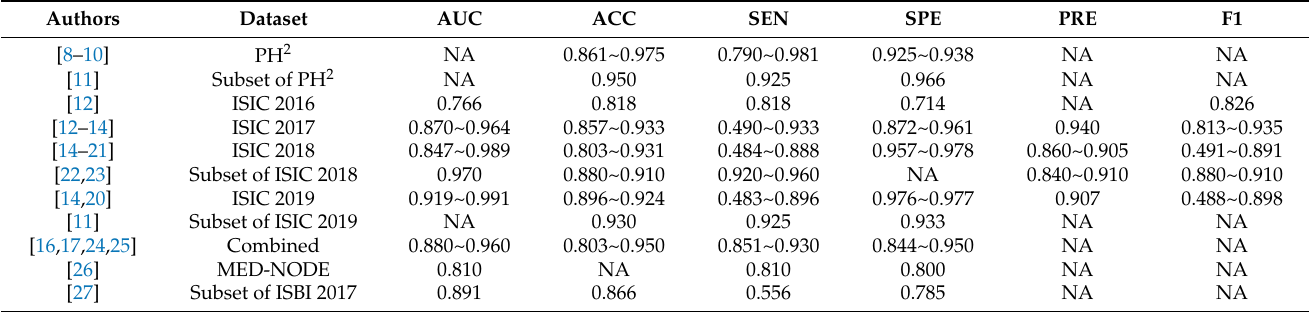
Table 1. Performance evaluation test results on the models’ melanoma binary